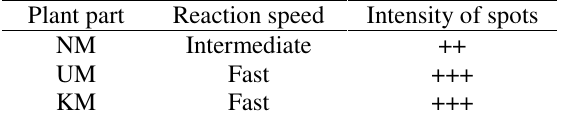
Table 3. Radical scavenging activities of the ethanolic extracts of UM, NM and KM using rapid DPPH TLC